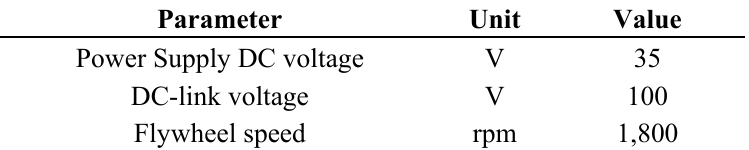
Table 9. Parameters used in measurement and simulation of complete driveline